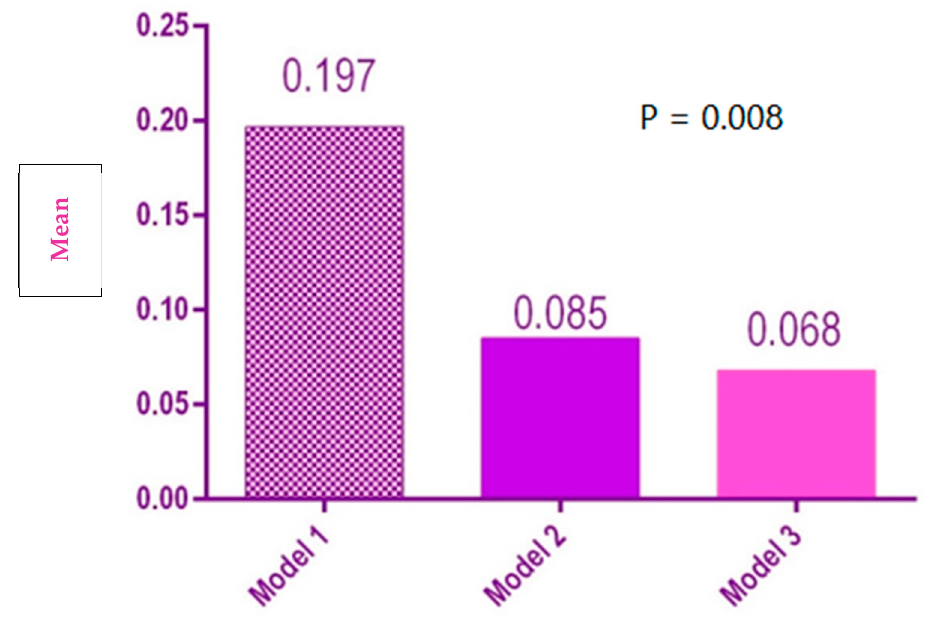
Figure 9. Statistical results of vestibular-oral distances for the 3 models. There was no significant difference between the interior distances for the three models (Figure 10).